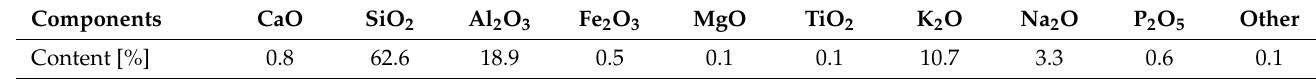
Table 4. Chemical composition of feldspar.